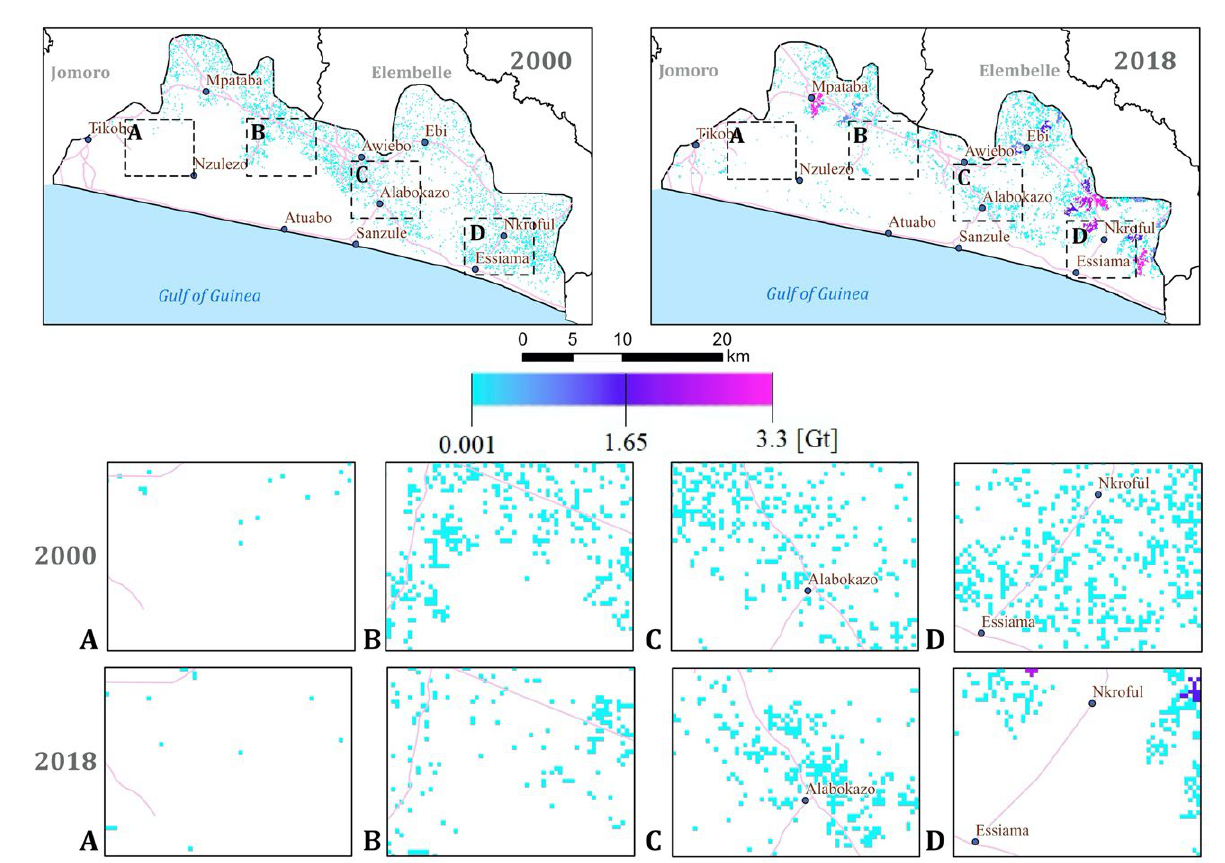
Figure 6. Quantities and distribution of food supply from plantain across the landscape in 2000 and 2018; ( A – D ) compares the spatial and temporal distribution of plantain food-crop supply potential for segments of the landscape.